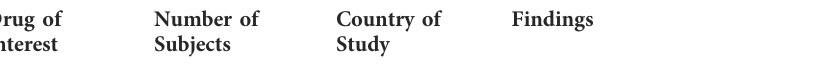
Country of Study